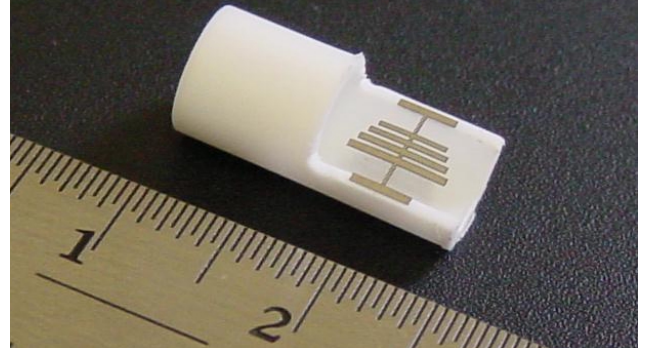
Figure 11. A four-element magnetoelastic sensor array mounted across a Teflon pipe. The longest sensor is approximately 6 mm in